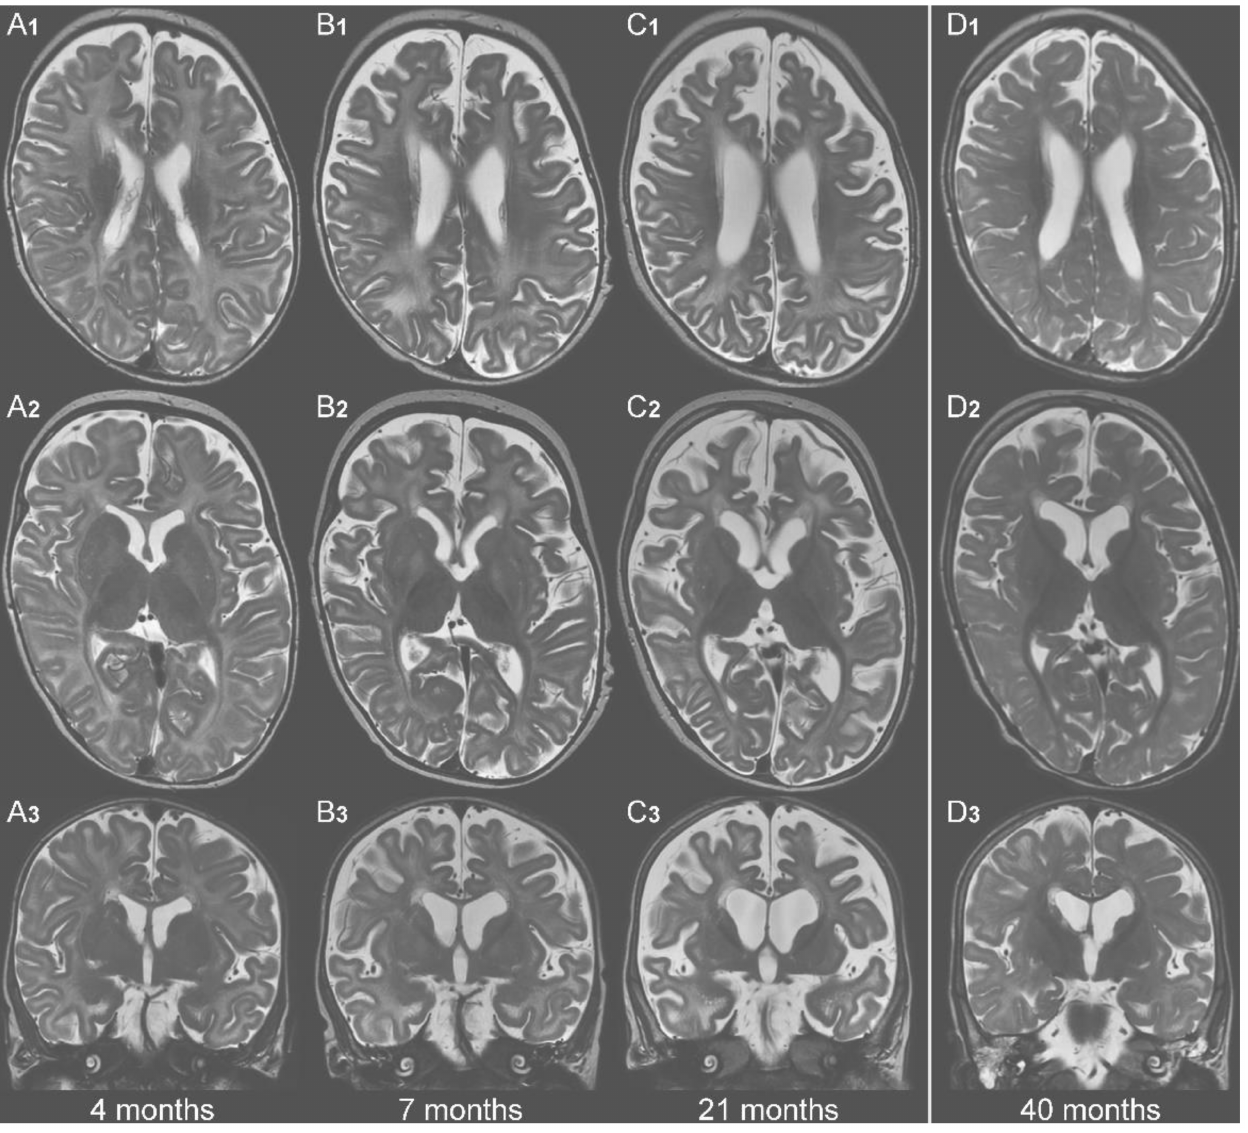
Figure 3. MRI course AGC1-1. Selected T2-weighted images from subject AGC1-1 at identical ana- tomical planes to allow comparison at four different time points: ( A1 – D1 ) at axial level through the upper part of the body of the lateral ventricles; ( A2 – D2 ) at axial level of the foramen of